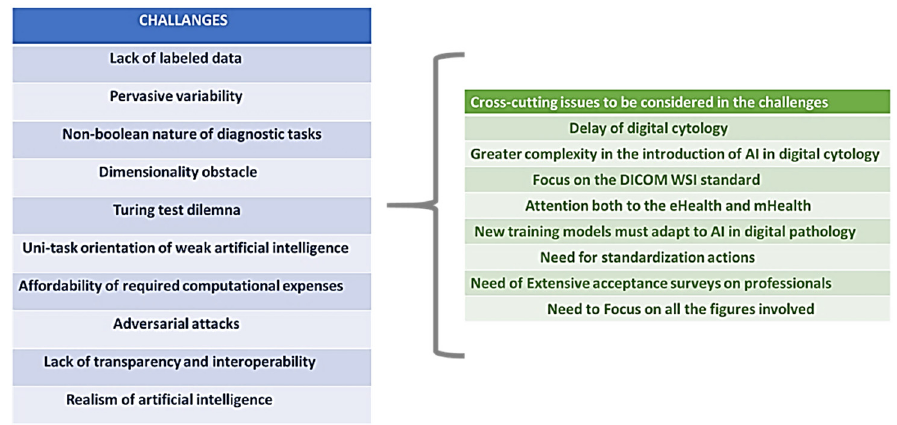
Figure 5. The challenges and cross-cutting issues emerging in the application of AI in DP. Further Cross-Cutting Issues